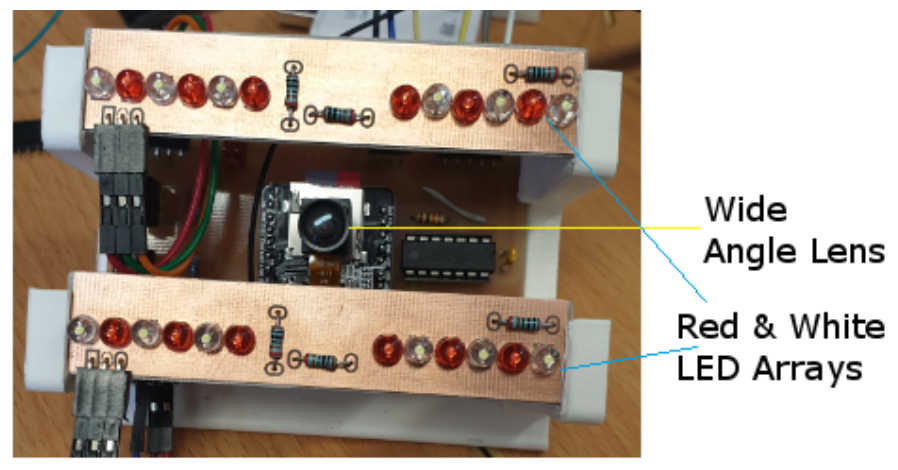
Figure 6. Artificial lighting for image illumination.